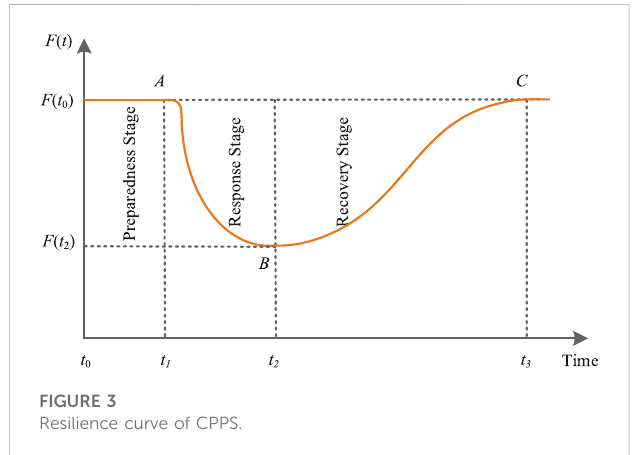
FIGURE 3 Resilience curve of